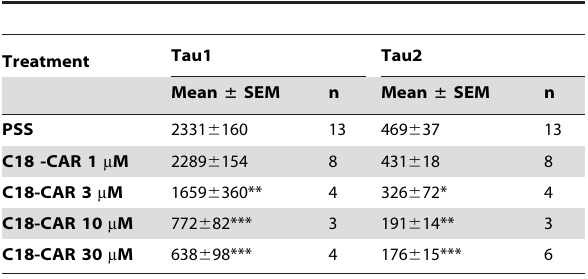
Table 2. Effect of different concentrations of extracellular C18-CAR on I hERG deactivation time constants.